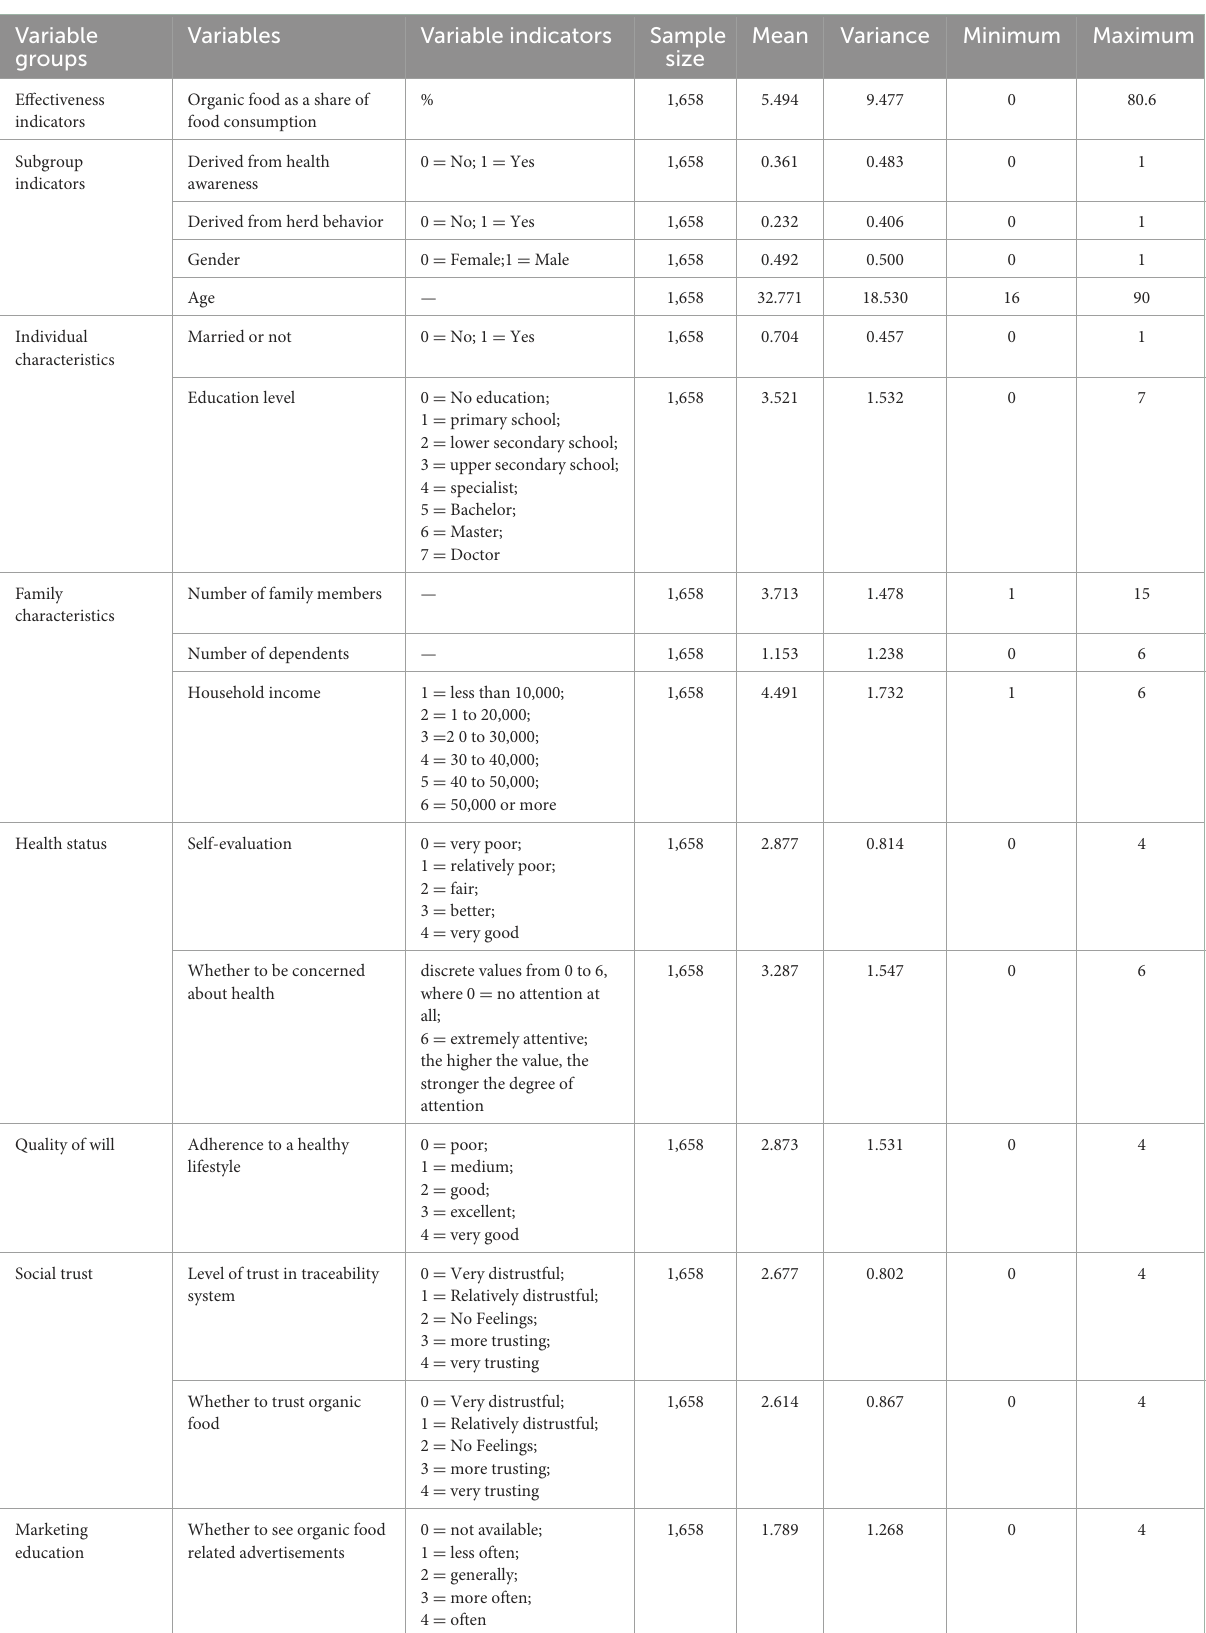
TABLE 2 Results of descriptive statistics for